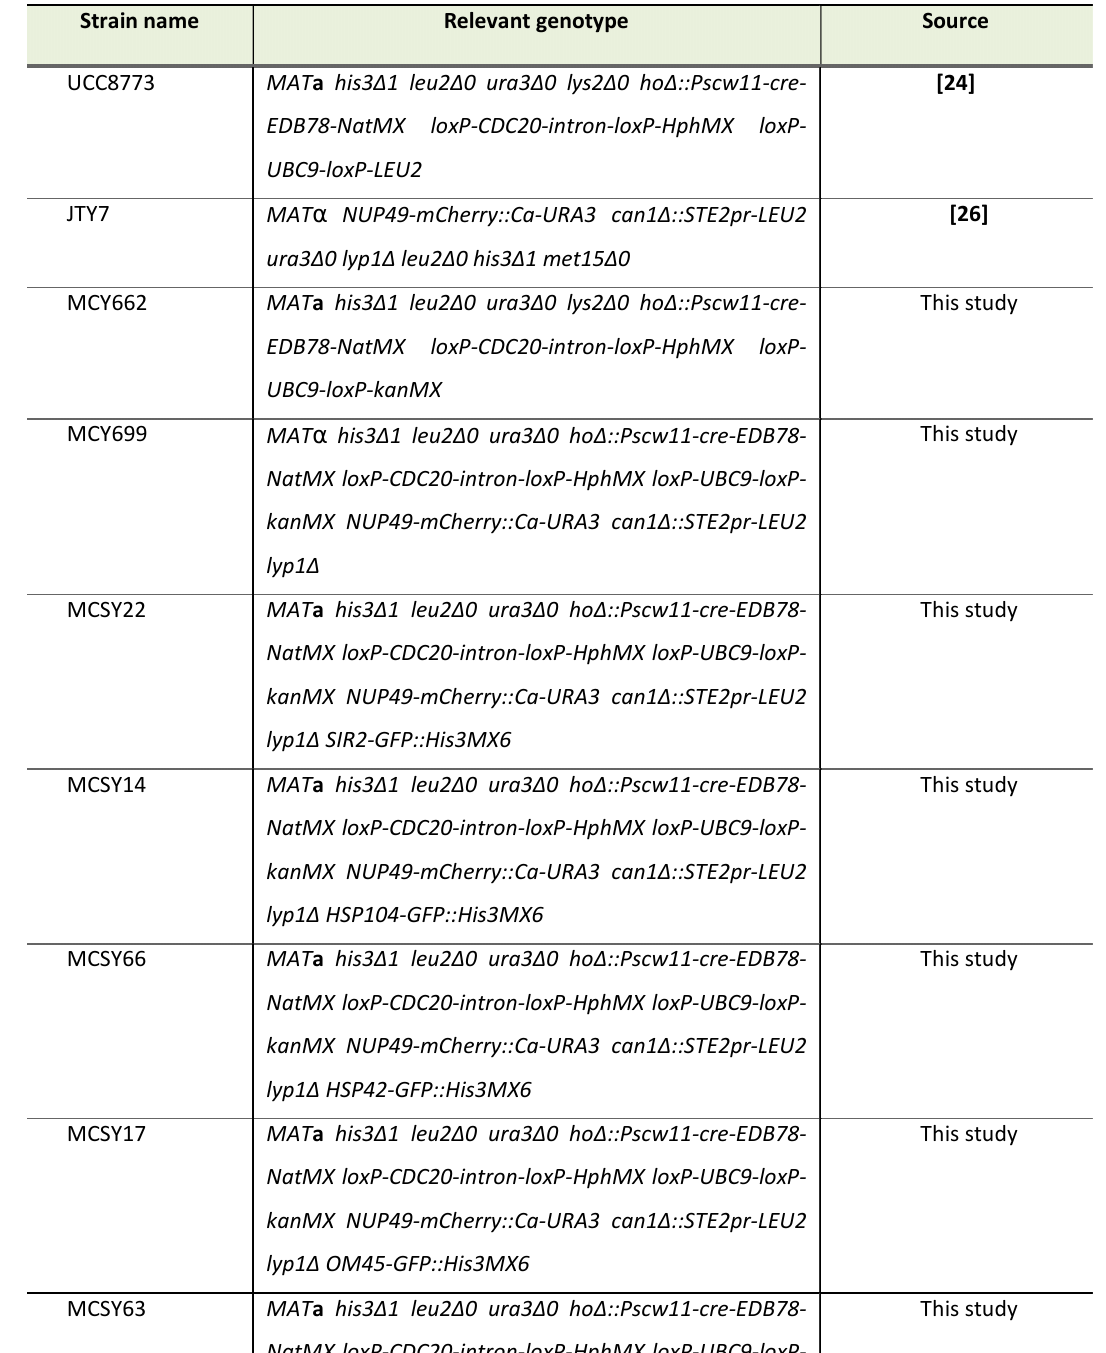
Table 1. Yeast strains used in this